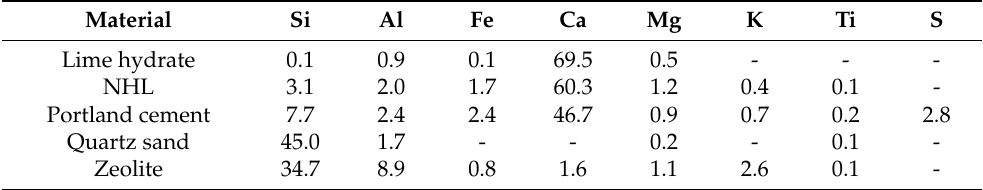
Table 2. Chemical composition of base materials (wt.%) obtained by XRF.